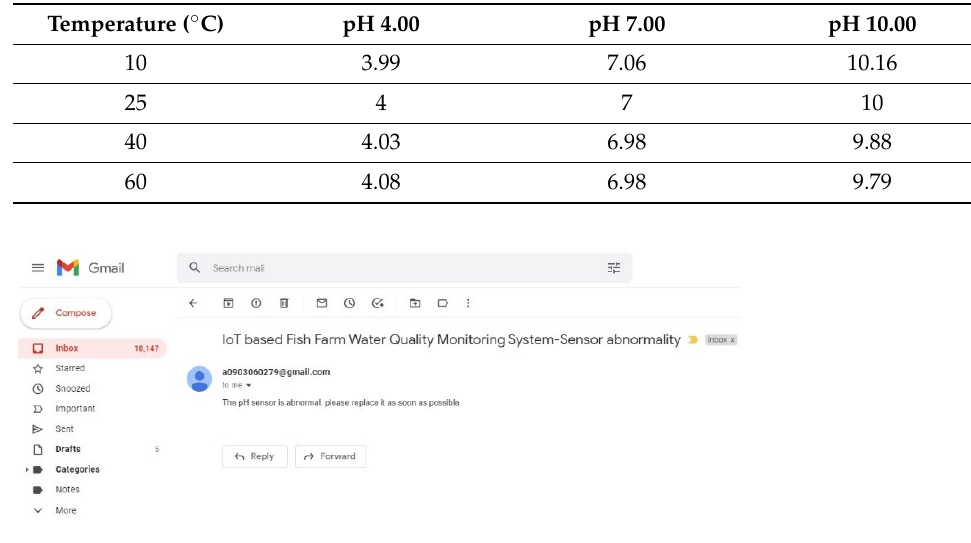
Figure 15. The alert e-mail.